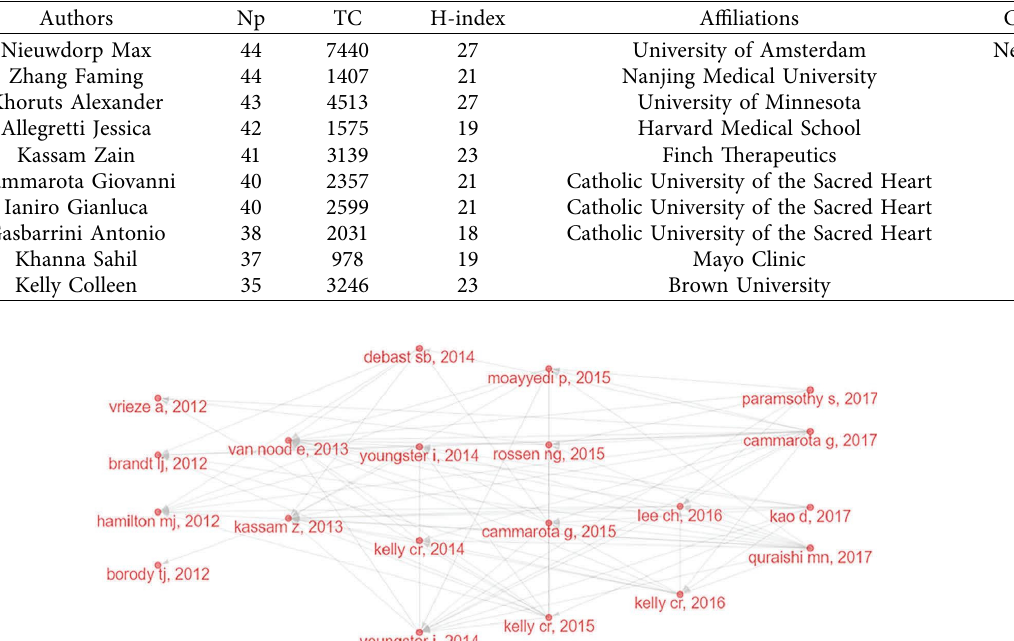
Figure 4: (a) Global scientifc output and international cooperation network (the shade of color represents the national output; the more intense the blue, the greater scientifc production. Grey shows countries without scientifc production; the red line shows the cooperation, the thicker the boundaries, the greater the cooperation degree). (b) Annual output of the top 20 high-prolifc countries in FMT (the circle’s size manifests the national output; the bigger the circle, the more publications). (c) Annual output of the top 10 high-prolifc institutions in FMT. (d) Te top 10 funding organizations in FMT research. (e) Annual output of the top 20 most prolifc writers in FMT research throughout time (the circle’s size symbolizes the output, with larger circles representing more output; the circle’s depth symbolizes the annual citations, with darker colors representing more citations). Table 4: Te top 10 high-yield authors in FMT research.